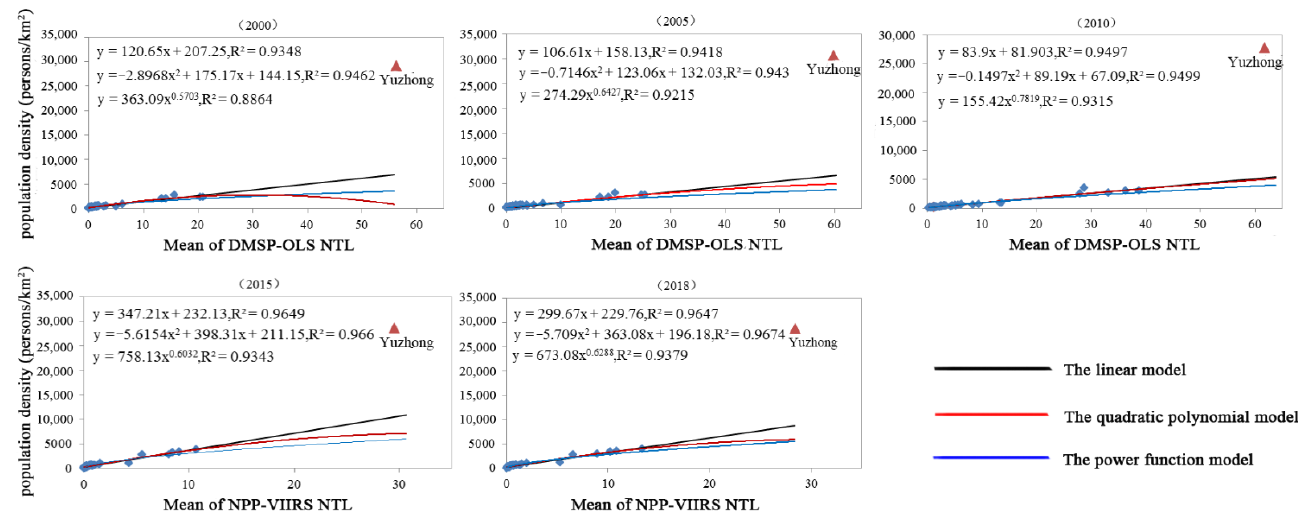
Figure 3. Relationship between light intensity and population density at the county level in Chongqing. Table 1. Correlation analysis between population and land-use type (by